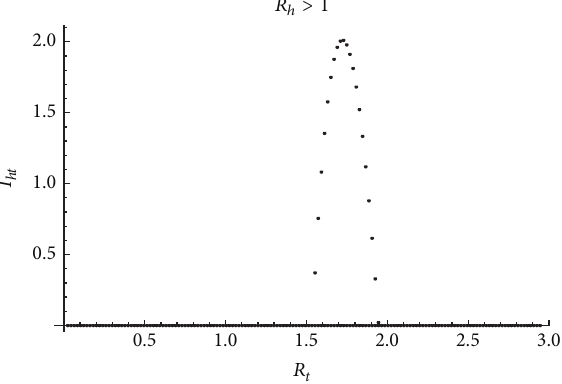
Figure 3: The bifurcation diagram for 𝑅 𝑡 versus 𝐼 ℎ .